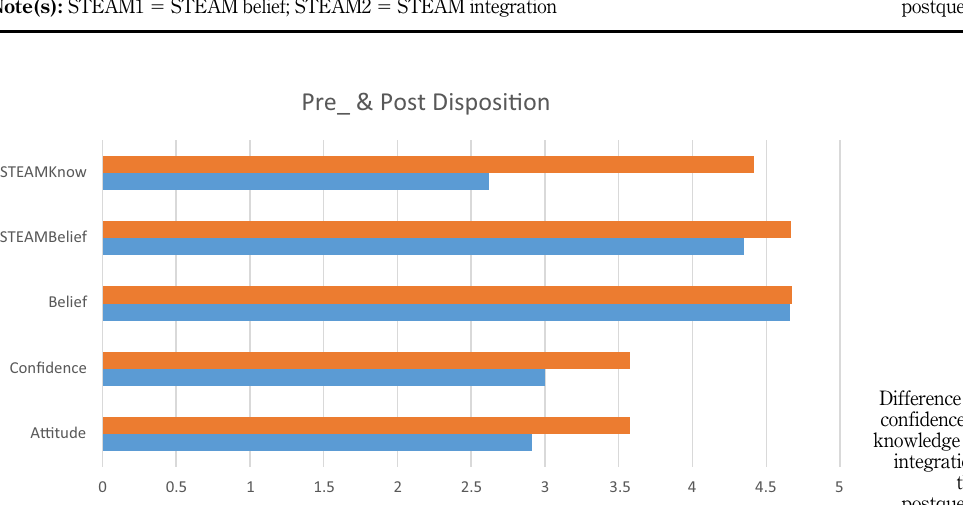
Figure 2. Difference in